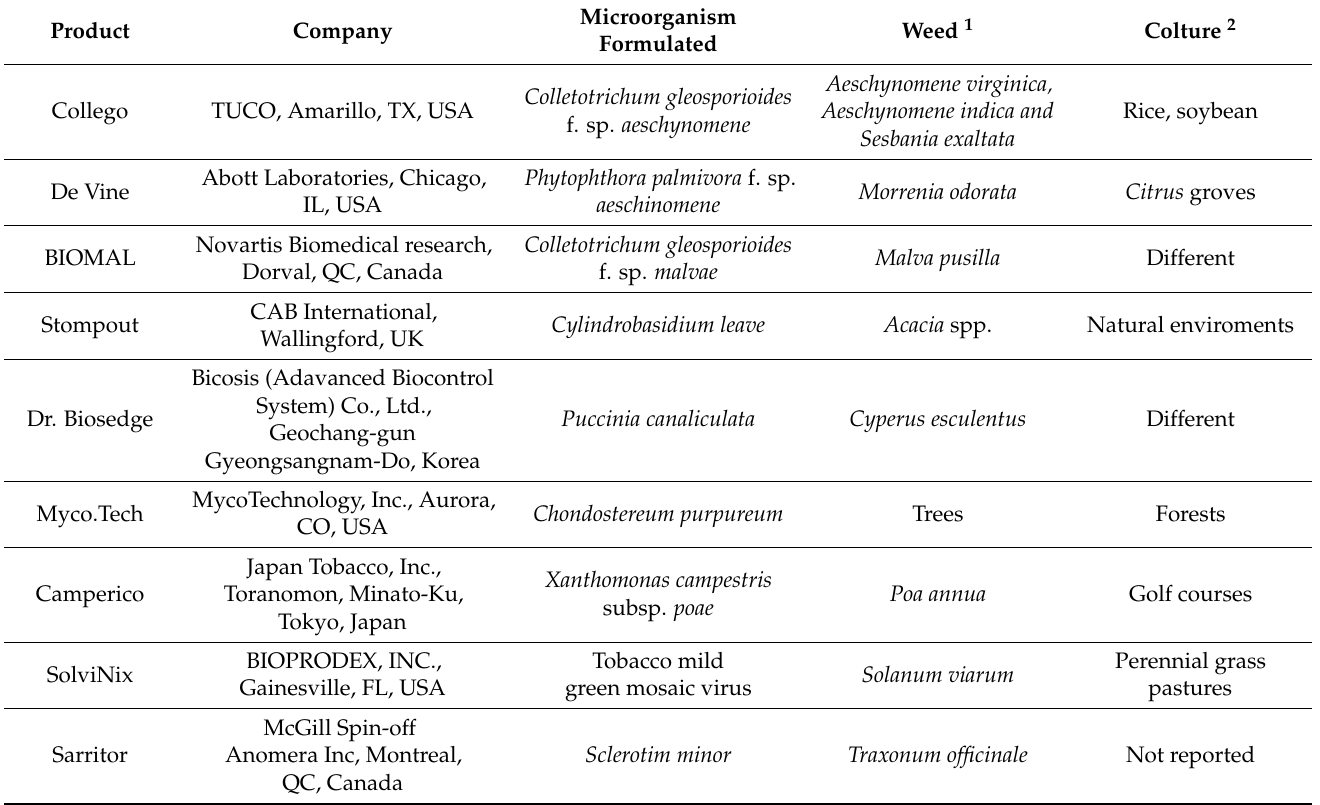
Table 1. Bioherbicides commercially